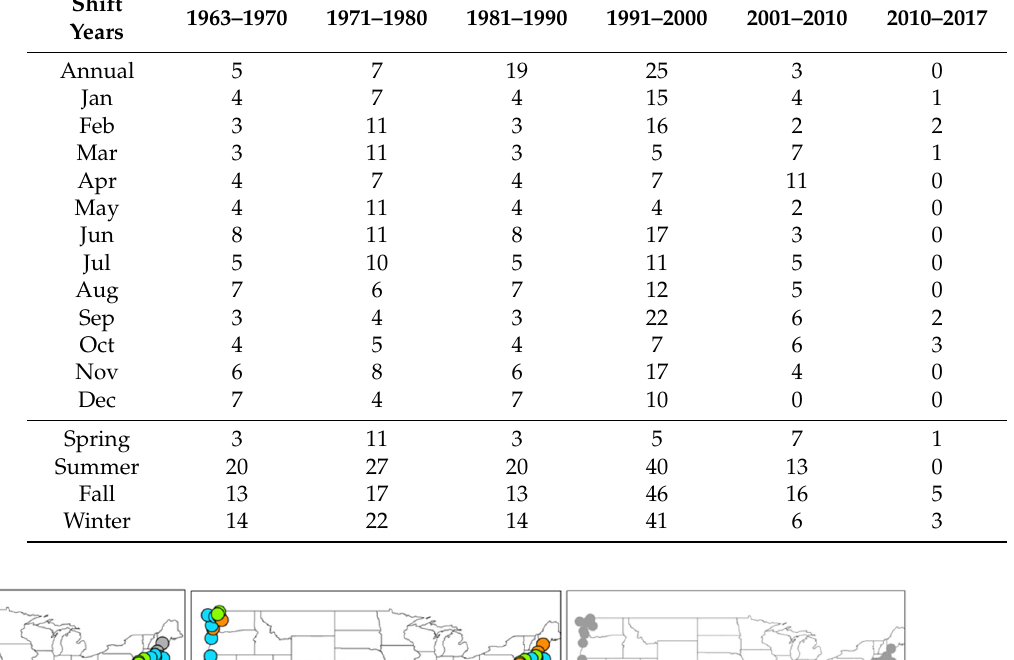
Table 2. Number of stations in different months at different time intervals and four seasons show- ing shifts.